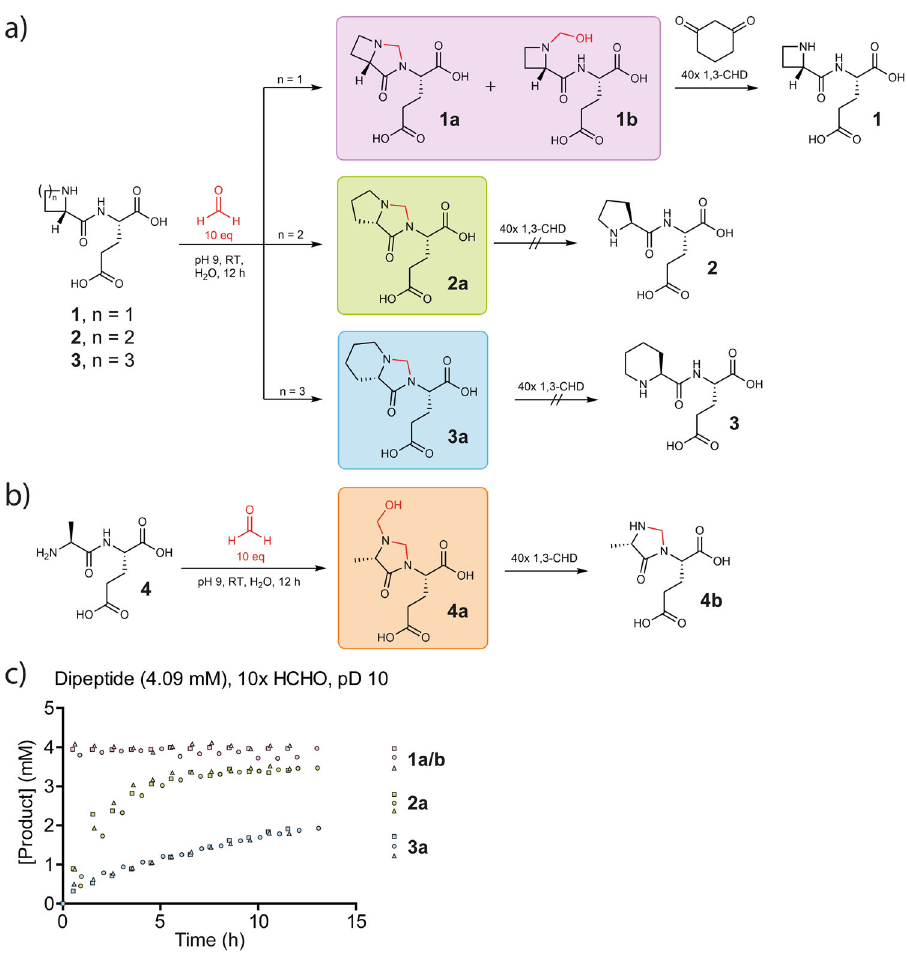
Fig. 3 HCHO reacts with an N-terminal proline to form a methylene bridge between an N-terminal nitrogen and the adjacent peptide bond nitrogen. a Products of reactions between HCHO and the dipeptides AzeGlu ( n = 1, 1 ), ProGlu ( n = 2, 2 ), and PipGlu ( n = 3, 3 ). A 10-fold molar excess of aqueous HCHO (410 µ mol) was added to each dipeptide (41 µ mol). Products containing apparent methylene bridges were observed with all peptides, although the methylene adduct formed with 1 ( 1a ) degraded after addition of the HCHO scavenger 1,3-cyclohexandione (1,3-CHD, 40-fold excess). b AlaGlu ( 4 , 41 µ mol) reacts with a 10-fold excess of HCHO (410 µ mol) at pD 12 and ambient temperature to form the methylene bridge-containing adduct 4a . Addition of 1,3-CHD (40-fold excess) results in loss of the HCHO-derived hemiaminal from 4a , forming 4b . c Graph showing NMR time-courses monitoring reaction of a 10-fold HCHO excess with dipeptides 1 – 3 at pD 10 ( n = 3 independent replicates); 4 did not react to give an observed product under these conditions (Fig.